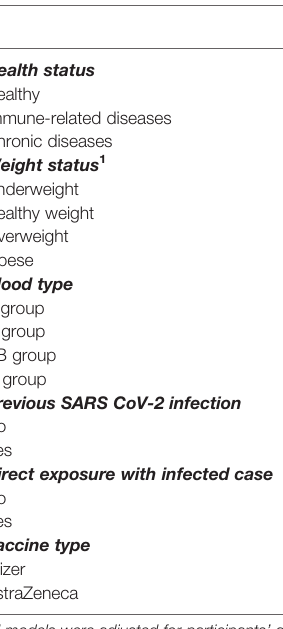
TABLE 4 | Predictors of change in the anti-S IgG antibody status after the fi rst and second dose (n =